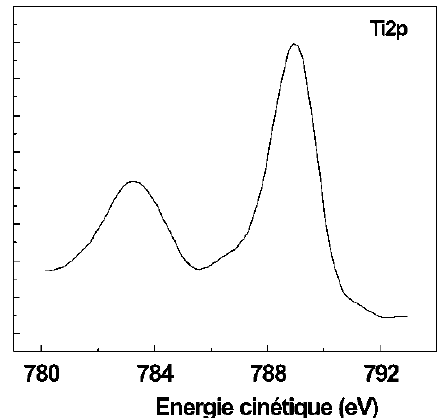
FIGURE 3b Spectre du niveau de cœur Ti2p dans le TiO 2 .